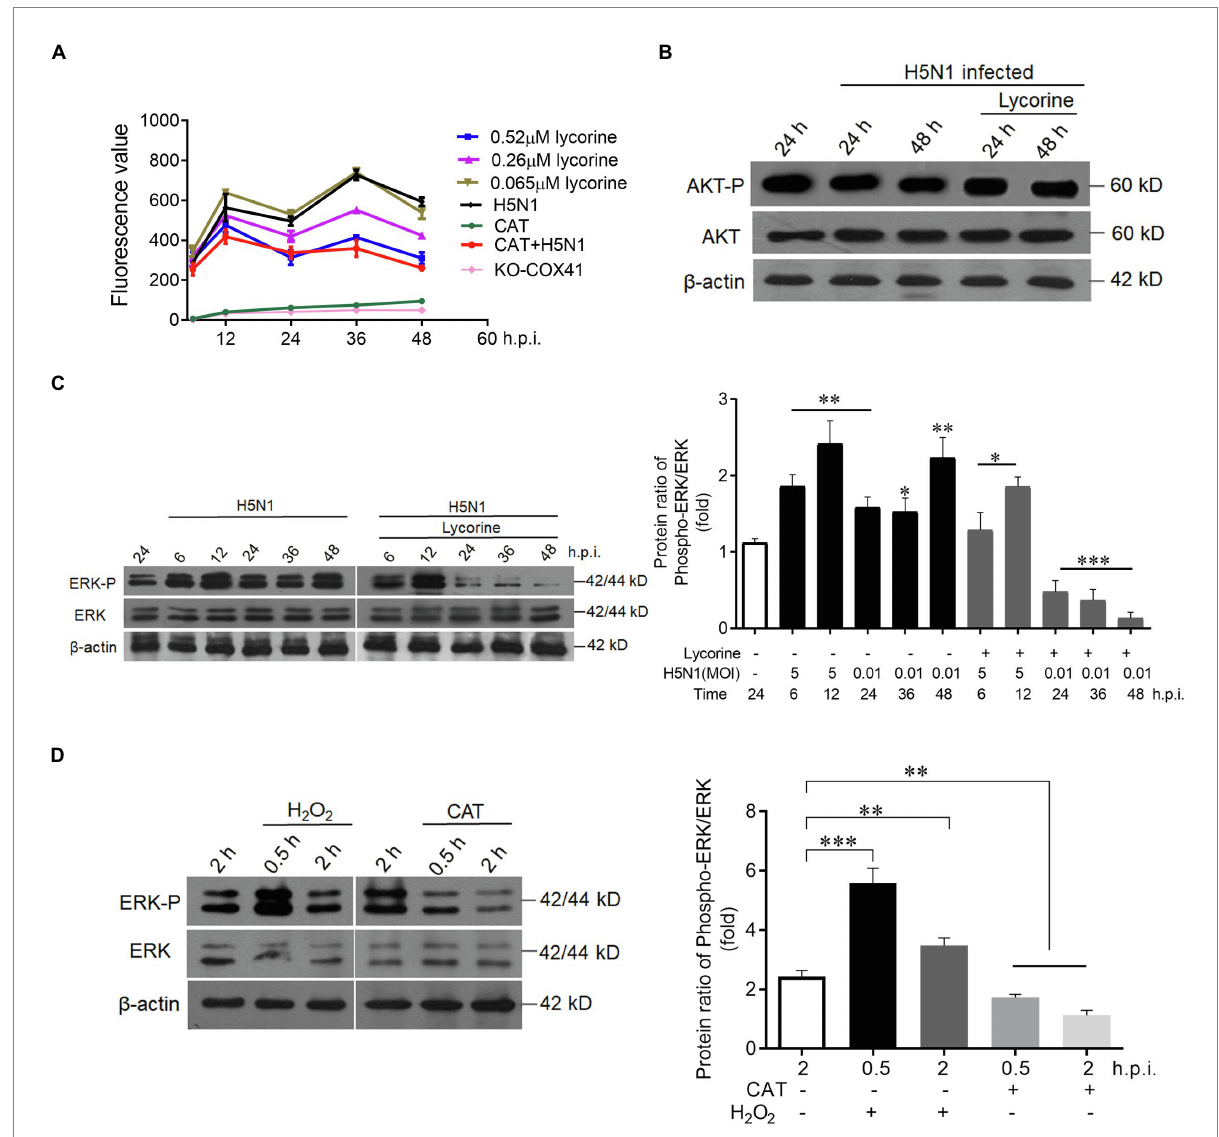
FIGURE 4 Lycorine inhibited the expression of COX41 through the ROS-ERK1/2 axis. (A) Lycorine suppressed the production of H5N1-induced ROS in wild-type cells or COX41-KO-1 cells. Catalase (CAT, 1 mg/ml). Data are mean ± s.d. ( n = 3). (B) Lycorine did not affect PI3K/Akt signaling in MDCK cells that were treated with lycorine (0.52 μ M) at the indicated time points after the viral infection. (C) Western blot and quantitative analysis of the inhibitory effect of lycorine on phosphorylation levels of ERK. MDCK cells were infected with H5N1 in the absence or presence of lycorine (0.52 μ M). The protein levels were detected at indicated time points postinfection. Data are mean ± s.d. ( n = 3). * p < 0.05; ** p < 0.01; *** p < 0.01. (D) ROS increased phosphorylation levels of ERK. H 2 O 2 (1 mm, a ROS activator) and CAT (1 mg ml − 1 , a ROS inhibitor) were used to test the phosphorylation of ERK. Data are mean ± s.d. ( n = 3). * p < 0.05; ** p < 0.01; *** p <